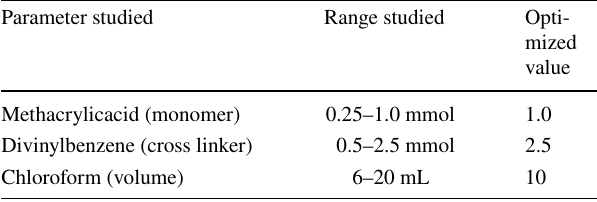
Table 2 Optimization of the amounts of cross linker, monomer